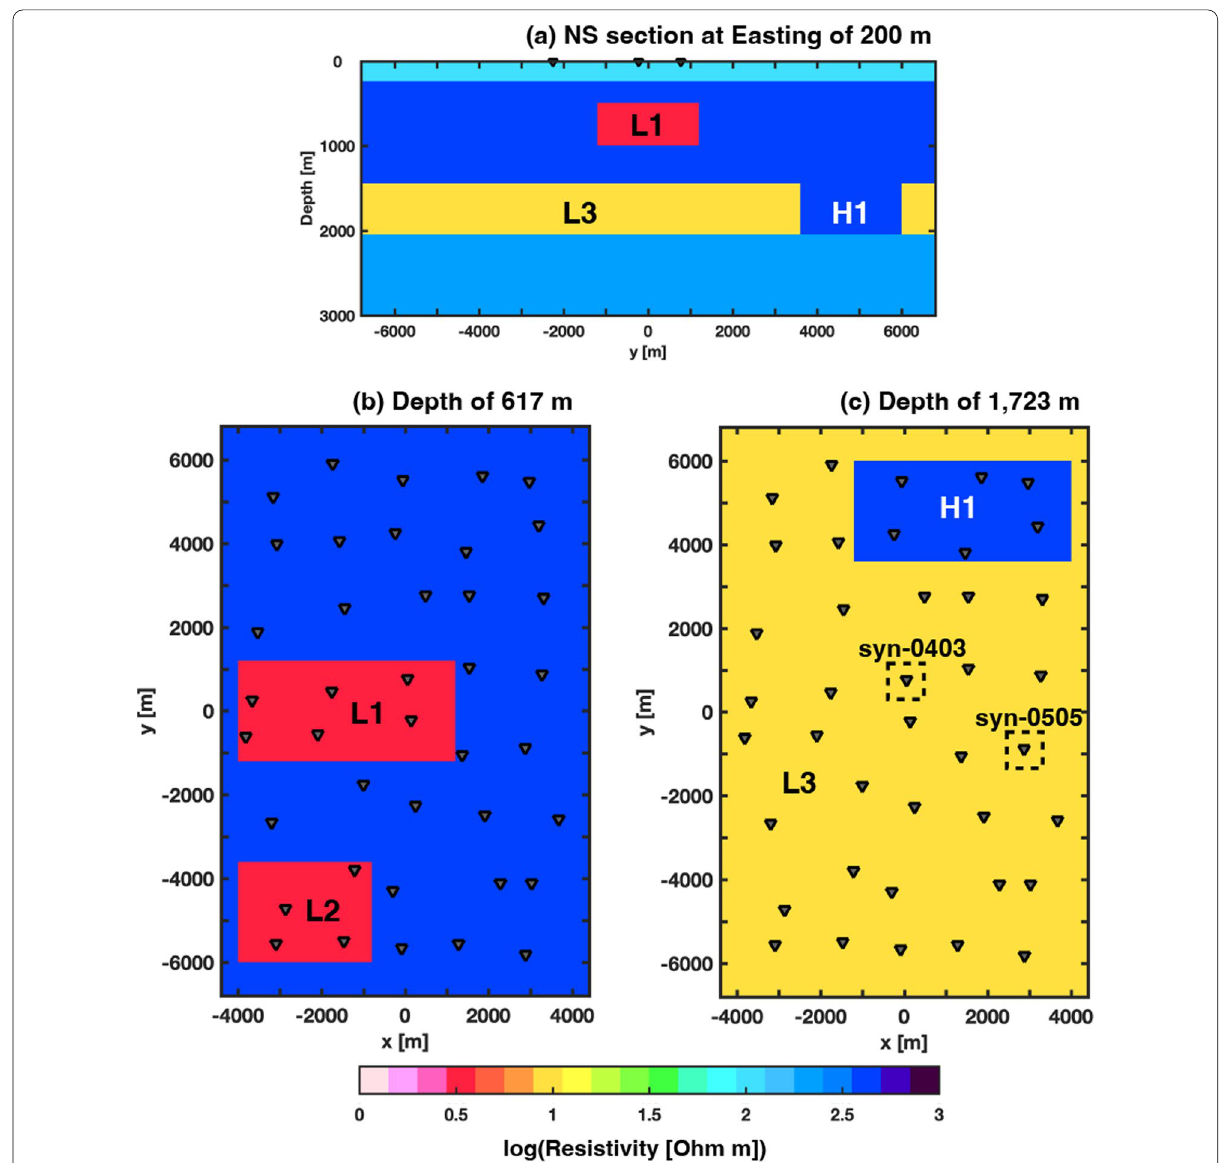
Fig. 1 Synthetic model used in this